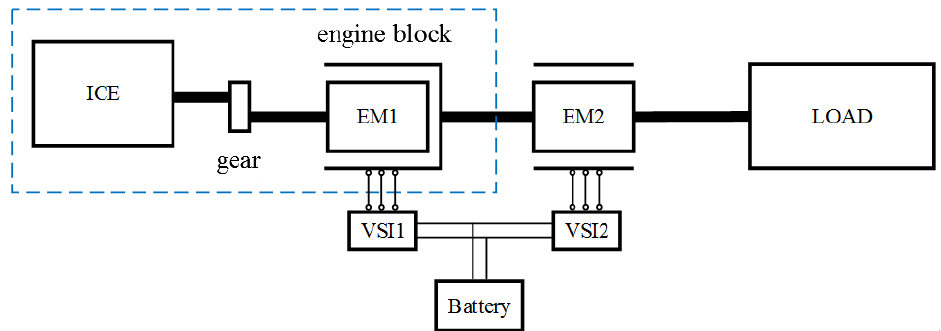
Figure 9. ICE group block diagram.